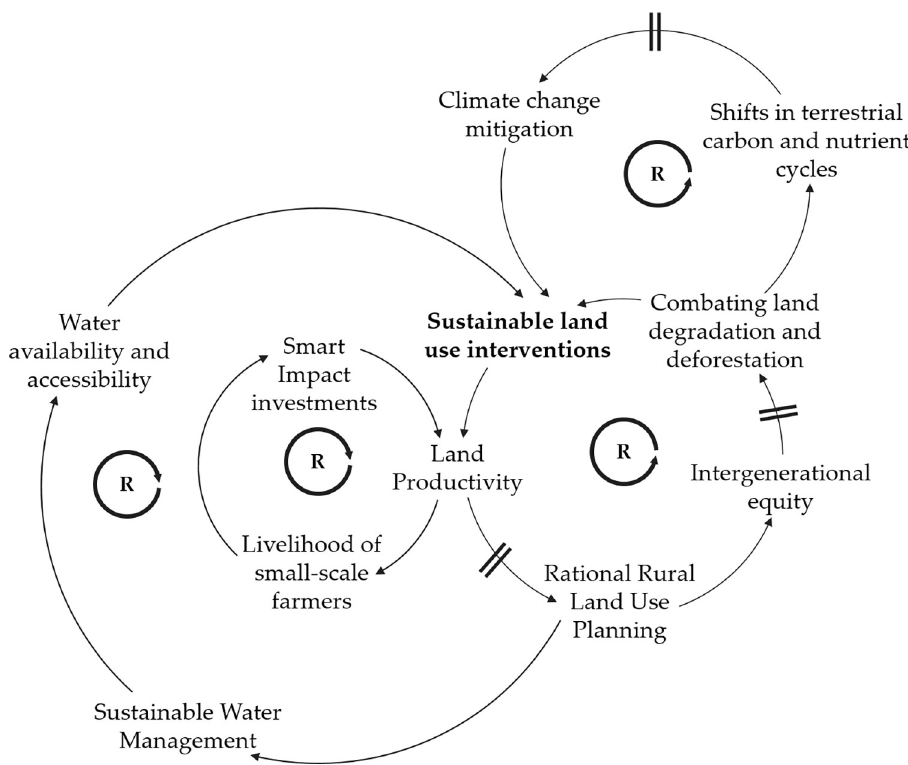
Fig 5. Key factors for effective design and implementation of sustainable land use systems to reduce deforestation and enhance peacebuilding in Colombia. Based on the policy brief elaborated by the same authors: Bonatti et al . [96].